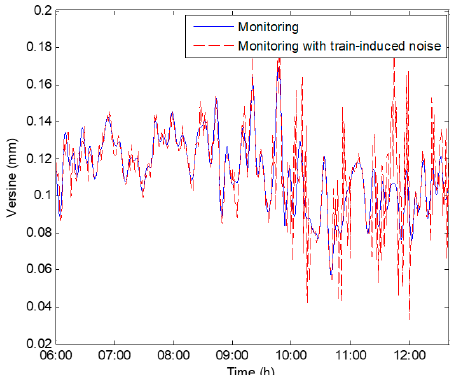
Figure 7. Data with the train-induced noise for VHGP training.